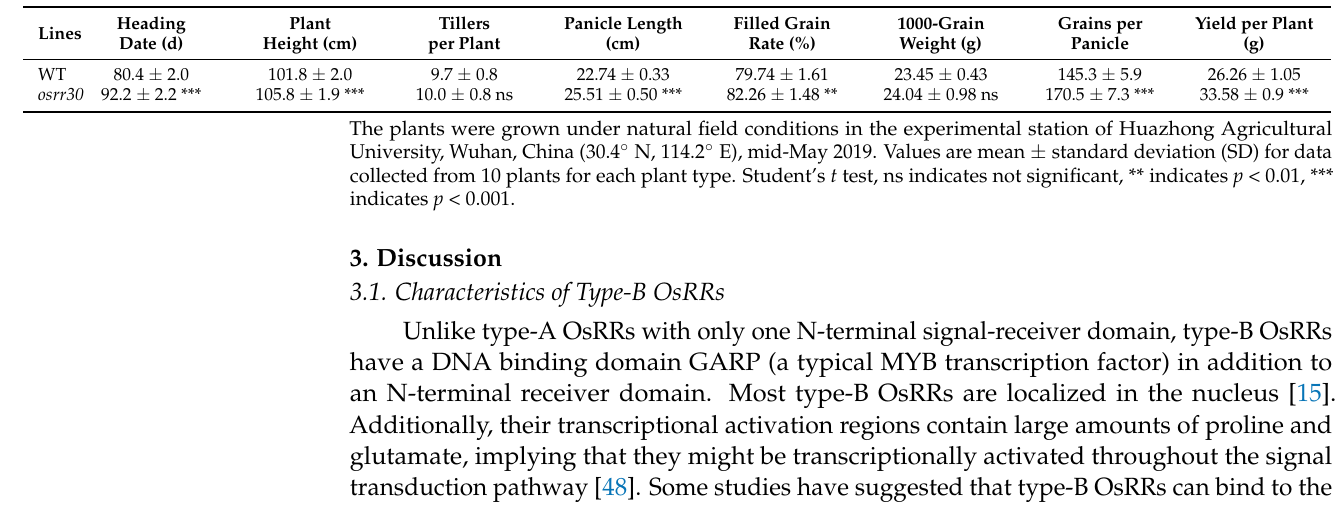
Figure 7. Delay of heading and improvement of yield and quality of osrr30 mutant. ( A ). Gross morphology of osrr30 and WT. ( B ). Heading date of osrr30 and WT under natural long-day conditions (NLDs) and natural short-day conditions (NSDs) in Wuhan. ( C ). Transcription levels of flowering- related genes in WT and osrr30 plants under LD (upper) and SD (down) conditions. ( D ). osrr30 showed improvement of yield and reduction of chalkiness rate. Student’s t test, *** indicates p < 0.001. Table 3. Agronomic performance of WT and osrr30